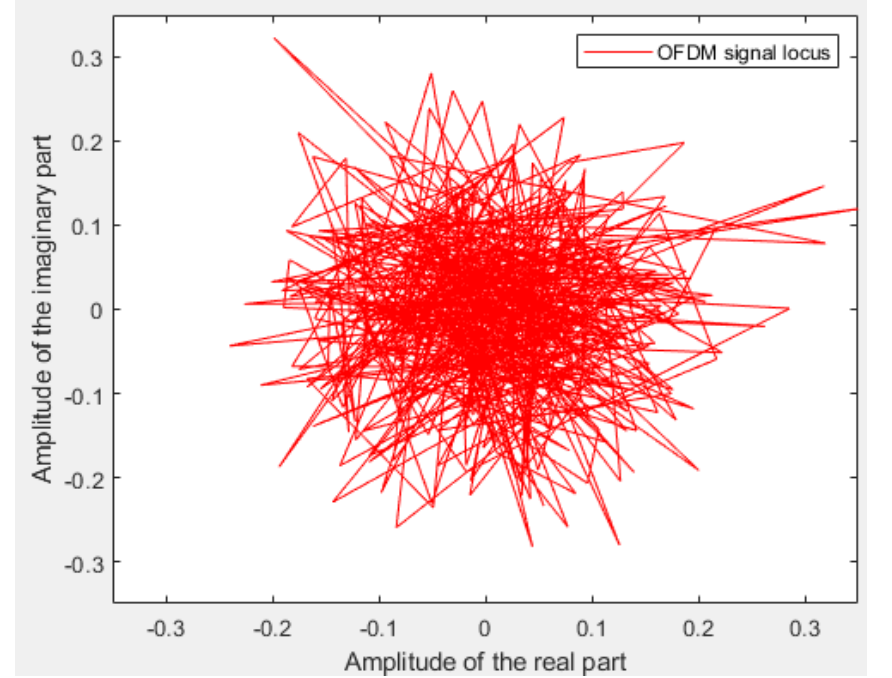
Figure 13. The power distribution locus for each subcarrier of the OFDM symbol.